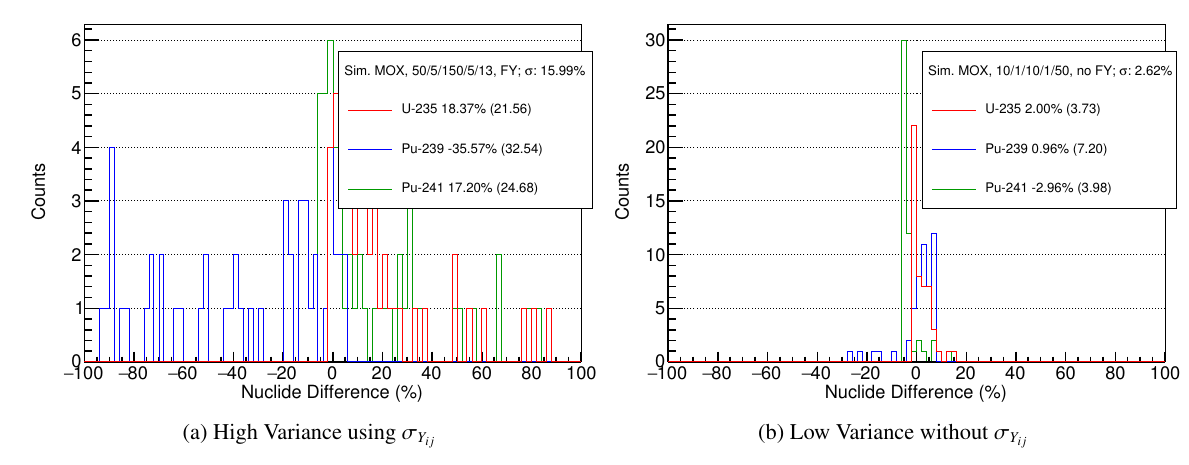
Figure 3: Average variance of mixed U and Pu material with the noted